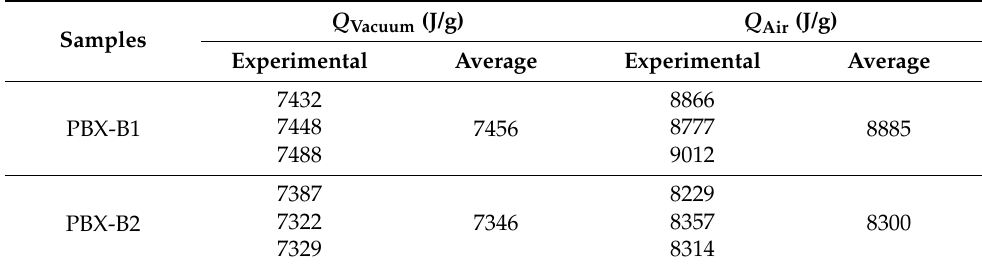
Table 1. Detonation heat values of boron-containing explosives. Q Vacuum (J/g) Q Air (J/g) Samples Experimental